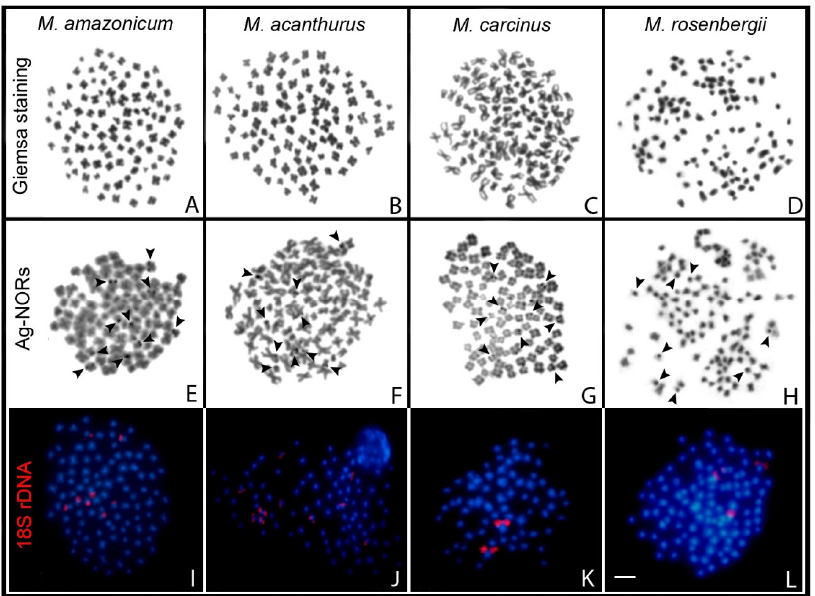
Figure 1. Spermatogonial metaphases of Macrobrachium amazonicus ( A , E , I ), M. acanthurus ( B , F , J ), M, carcinus ( C , G , K ), and M. rosenbergii ( D , H , L ) after Giemsa staining ( A – D ); Ag-NOR impregnation ( E – H ) and FISH with 18S rDNA (red) probe ( I – L ). Blue fluorescence represents chromosomes stained with DAPI and dark arrowheads highlight Ag + signals in the chromosomes. Bar = 5 µm. The mapping of the simple sequence repeats (SSRs) ((CA) 15 , (GA) 15 , (CAA) 10 , and (CGG) 10 ) showed a surprisingly large amount of accumulation/amplification distributed homogeneously along the chromosome arms. However, these sequences are absent in the centromeric regions, where large AT-rich heterochromatic blocks (DAPI + ) occur (Figure 2). No hybridization signal with the (TTAGGG)n probe was found in any species.